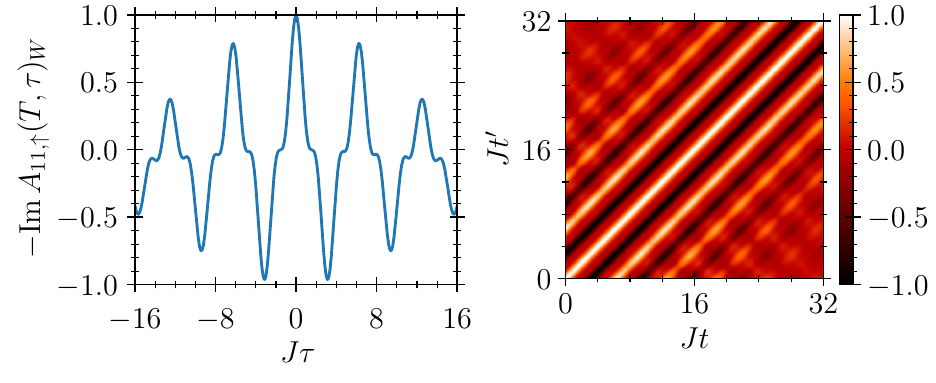
( T , τ ) Figure 10: The Fermi-Hubbard spectral function A at centre-of-mass time W 11, ↑ ( t , t (cid:48) ) (right) for settings as in Fig. 9. In the approx- J T = 16 (left) and − Im A 11, ↑ imation given by Eq. (58), the interaction produces a damping in the τ -direction, orthogonally to the equal-time